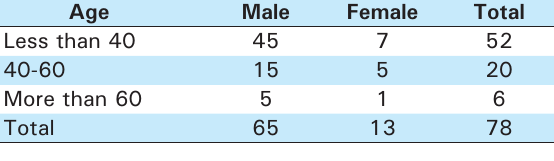
Table 1. Age and sex variations in study group (n=78)